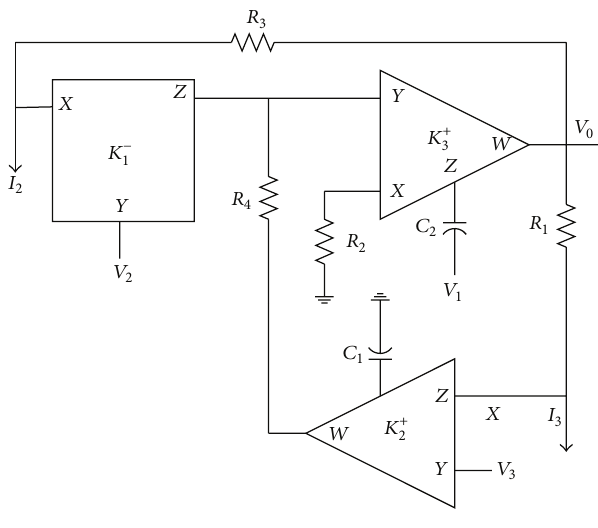
Figure 5: Second derived